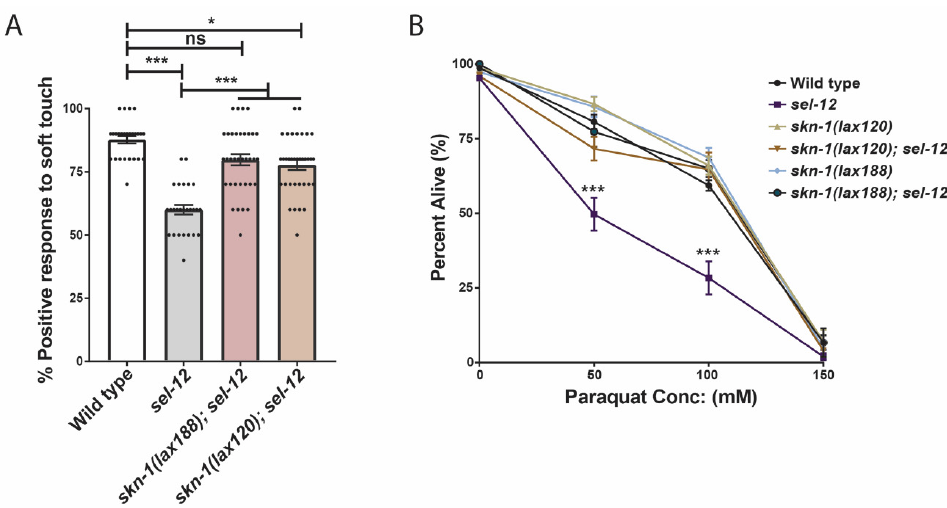
Figure 5. Activation of SKN-1 improves soft touch response and resistance to oxidative stress in sel-12 mutants. ( A ) Response to anterior and posterior soft touch in sel-12 mutants and sel-12 mutants carrying activating mutations in skn-1 . (n = 20) ( B ) Paraquat survival assay in wild type, sel-12 mutants, and animals carrying activating mutations in skn-1 after 24-h exposure to either 50, 100, or 150 mM paraquat (50 animals per strain, performed 3 times). ns p > 0.05, * p < 0.05, *** p < 0.001 using one-way ANOVA with Kruskal-Wallis test ( A ) or two-way ANOVA with Bonferroni test ( B ). Error bars indicate mean +/ − SEM.